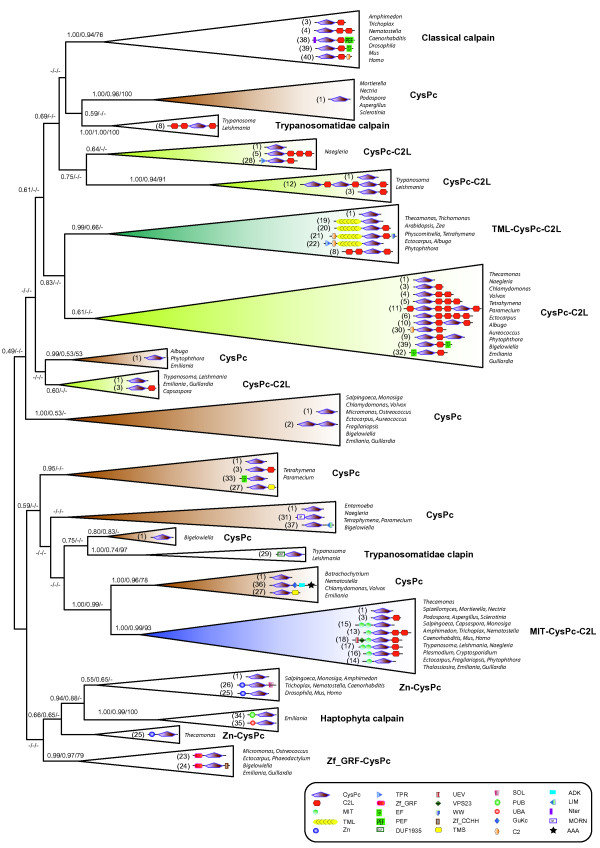
Eukaryotic calpain phylogeny reconstructed by Bayesian inference of the CysPc domain sequence. Several lineages that share similar domain combinations are collapsed into major clades for details of species names and protein domains, see Figure 1 and Additional file 2: Figure S1. Typical domain organization is schematically displayed in each clade. The names of domains are shown on the bottom with different symbols. Only the genus names of sampled taxa are listed. The clades representing four proposed ancestral domain architectures are color-coded (i.e. CysPc in dark brown, CysPc-C2L in blue, MIT-CysPc-C2L in light green and TML-CysPc-C2L in dark green). For each node, statistical support values are marked (numbers from left to right: Bayesian posterior probabilities (PP) inferred under LG /CAT models and maximum-likelihood bootstraps (% BP) inferred using PROTGAMMALG model). Dashes ‘-’ indicate support values < 50% BP or 0.5 PP.